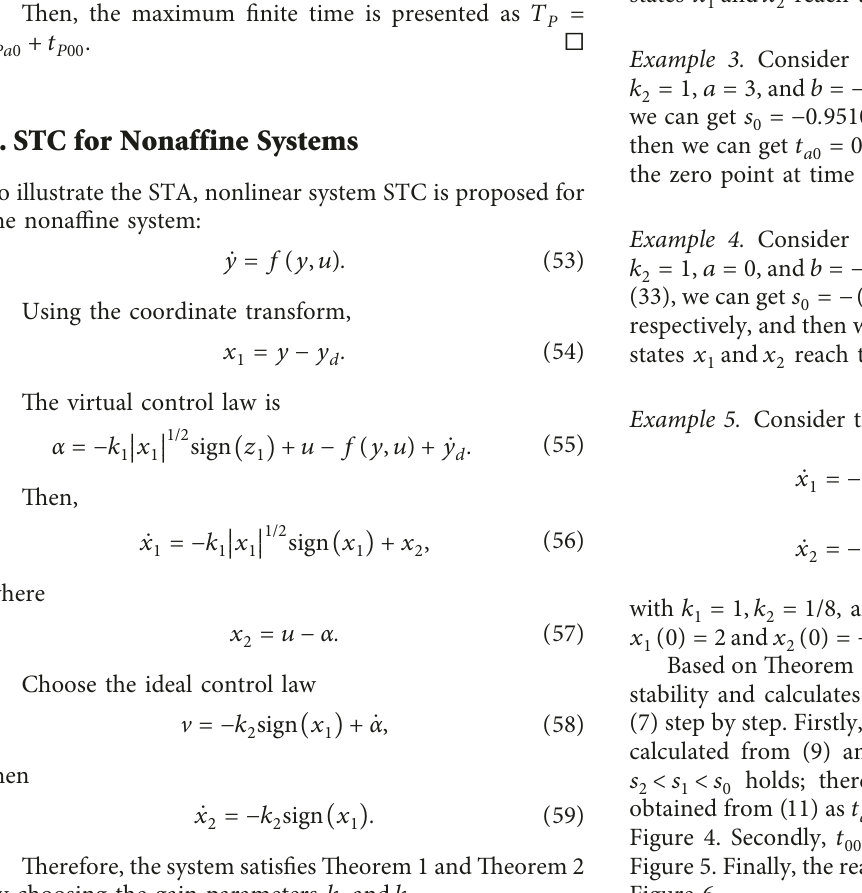
� 9 . 0256 is calculated from (17) in 00